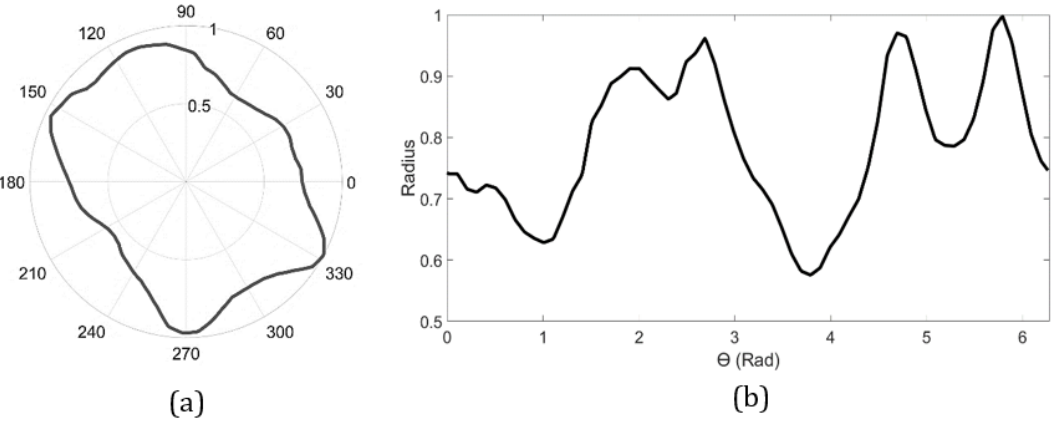
Figure 2. Representations of an aggregate shape using ( a ) a polar curve and ( b ) a signature curve.